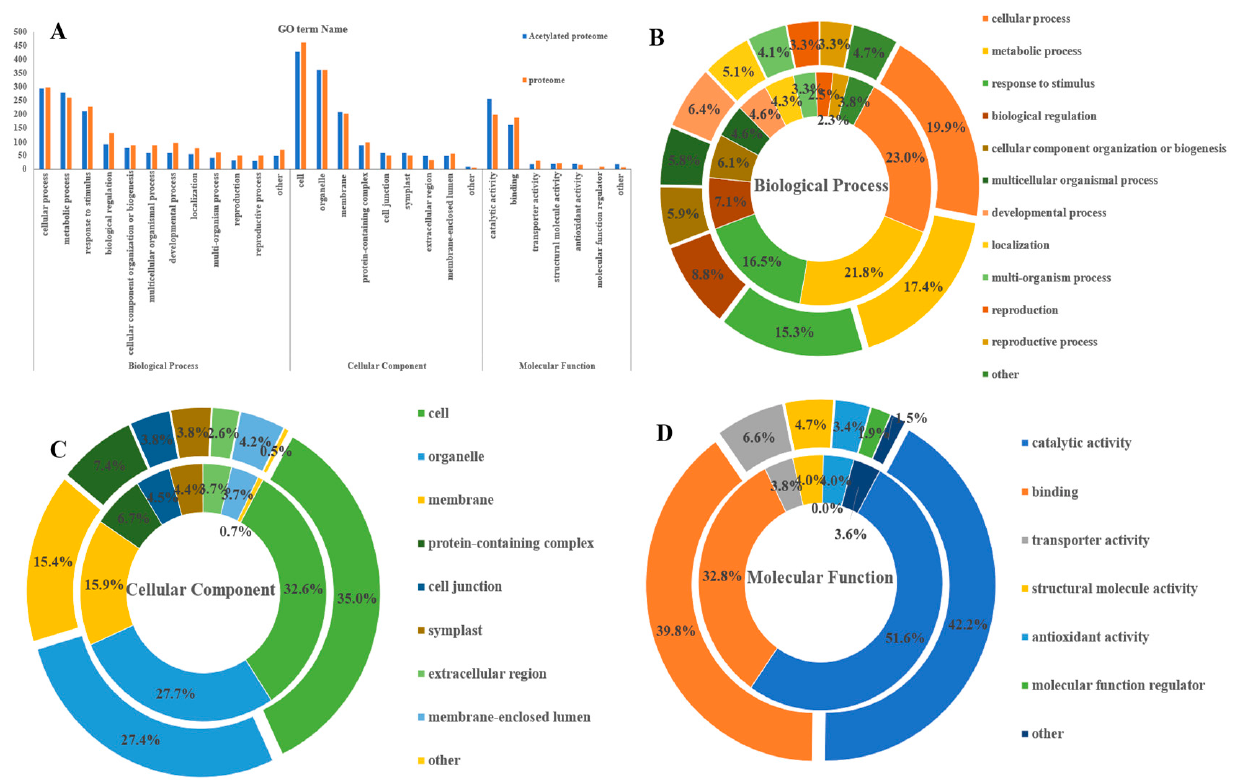
Figure 4. Analysis of differentially acetylated protein and differentially expressed protein GO under UV-B stress. ( A ) The GO terms of differentially protein and differentially acetylated protein; ( B ) The biological process of differentially protein and acetylated protein; ( C ) The cellular component of differentially protein and acetylated protein; ( D ) The molecular function of differentially protein and acetylated protein. The inner circle is differentially acetylated protein and the outer circle is differentially protein. Table 1. GO classification number of differential acetylated protein and differential expressed pro- tein under UV-B stress.